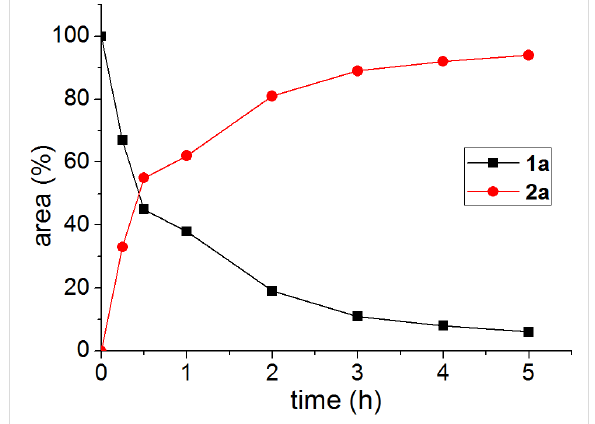
Figure 2: Time-course plot for the CAL-B catalysed hydrolysis of 1a .